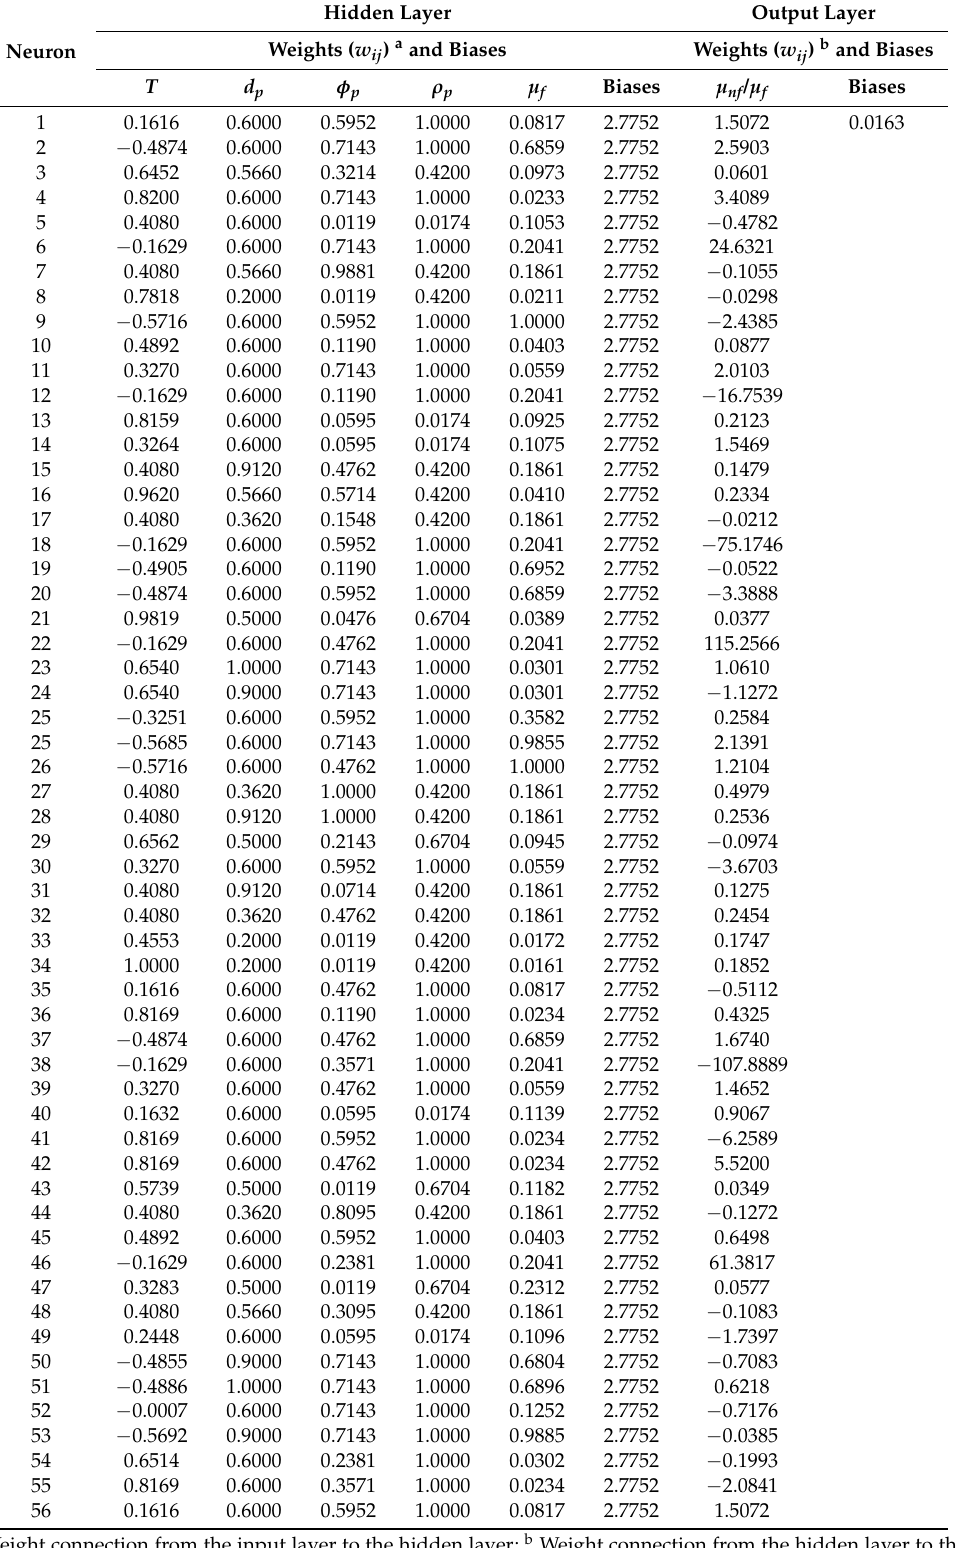
Table 3. Weight and bias coefficients of the developed RBF neural